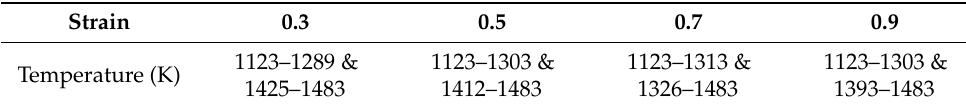
Table 2. Range of deformation temperature under each strain.